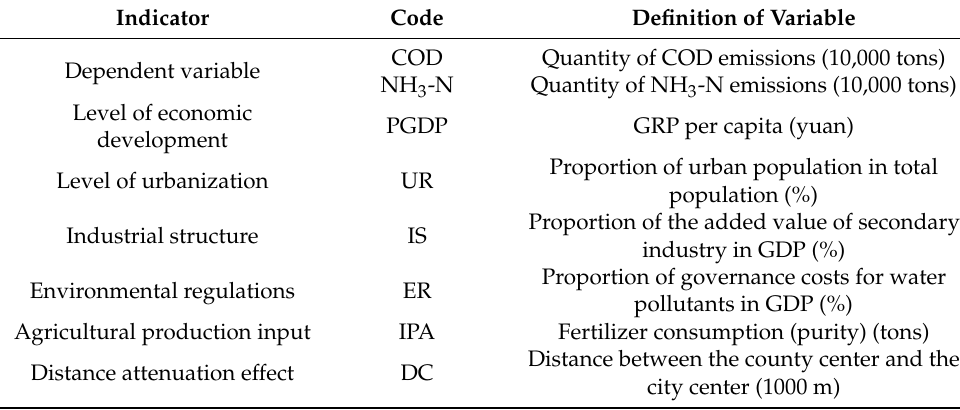
Table 1. Model indicators and